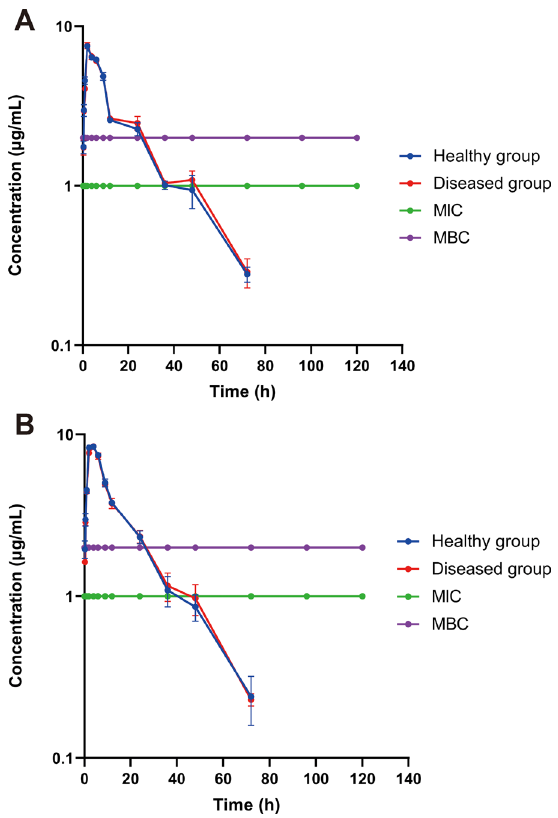
Fig. 2 Mean concentration versus time curves for DoxHcl&FF in PELF: FF ( A ), DoxHcl ( B